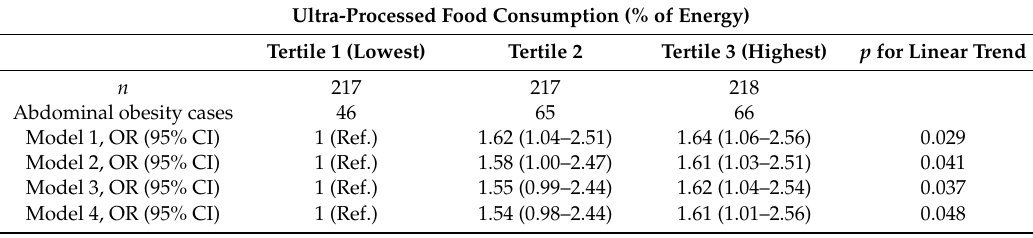
Table 2. Risk of abdominal obesity according to tertiles of ultra-processed food consumption in the Seniors-ENRICA 1